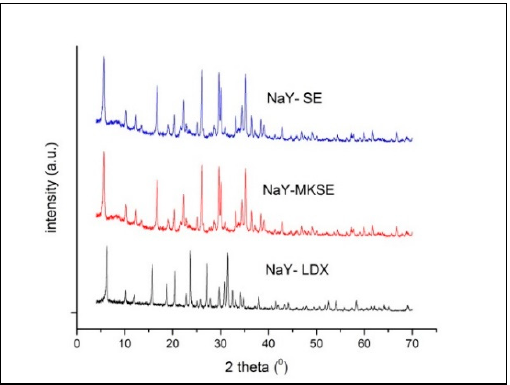
Figure 10. XRD data of as-synthesized NaY zeolites from natural and synthetic precursor materials: NaY-SE ( top ), NaY-MKSE ( middle ) and NaY-LDX ( bottom ).